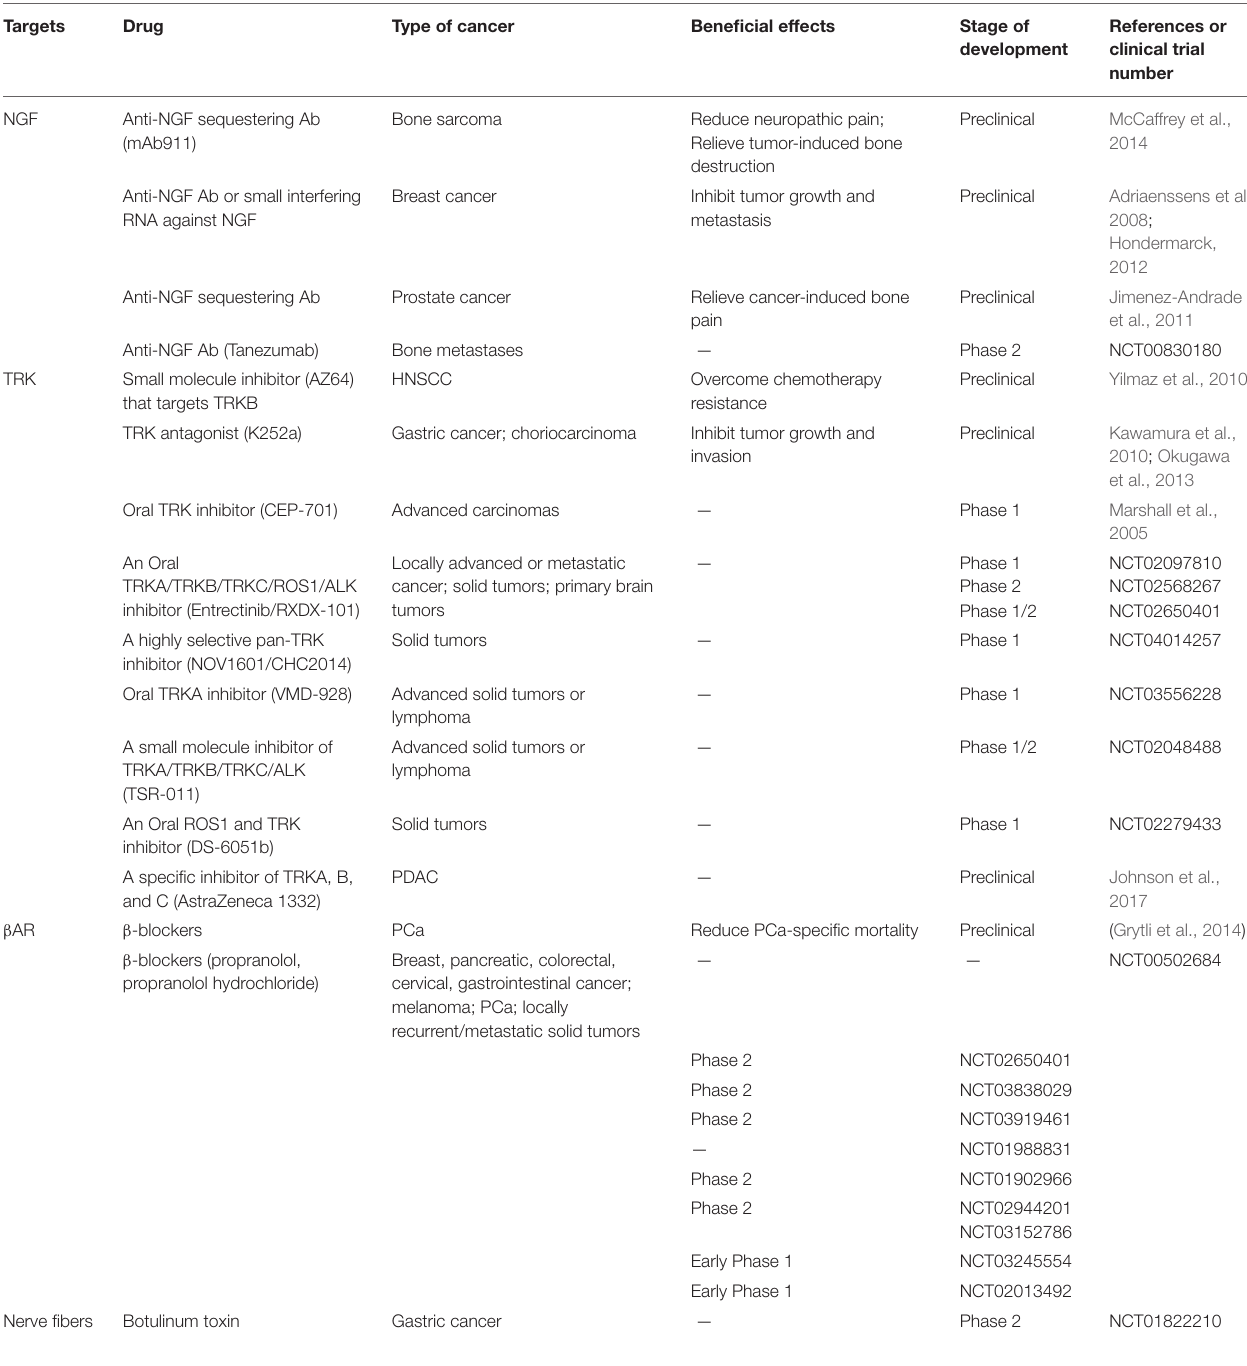
TABLE 2 | Therapeutic perspectives in cancer